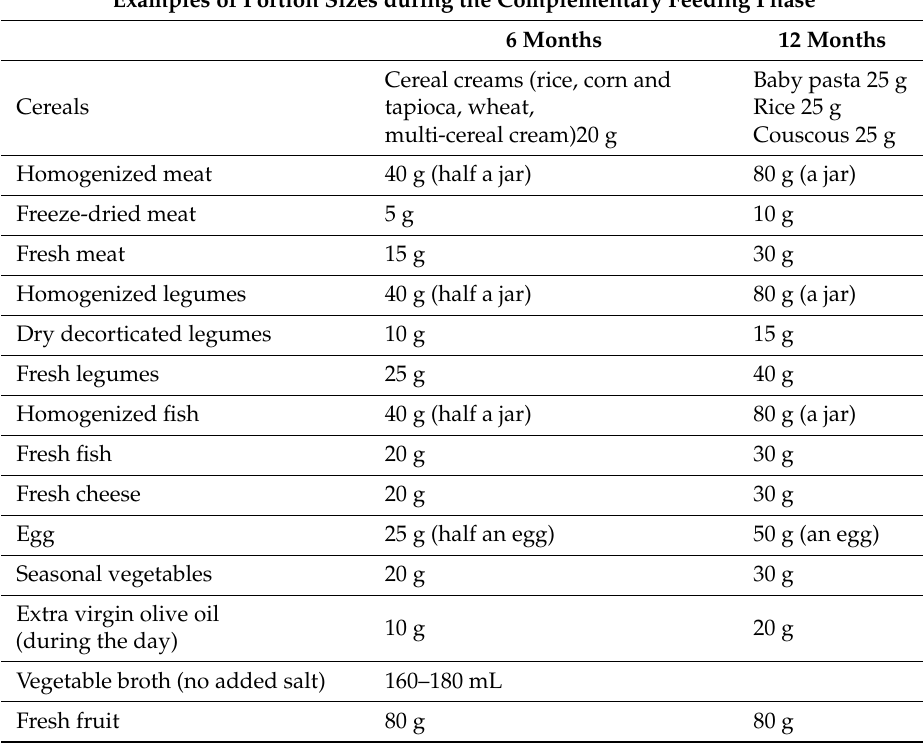
Table 2. Examples of portion sizes at 6 and 12 months during the complementary feeding